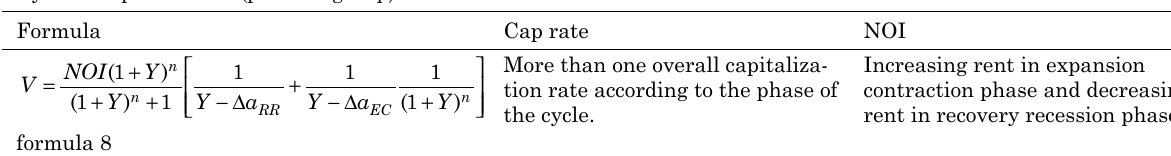
one only overall capitalization rate